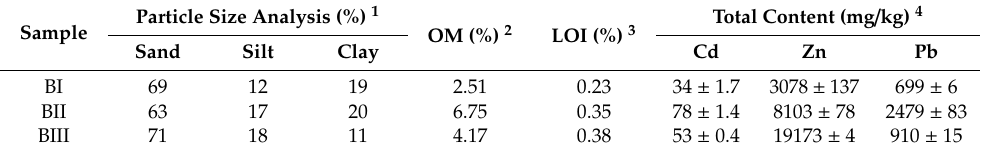
Table 1. Selected properties and concentrations of Cd, Zn, and Pb in the soils from BI, BII and BIII points [53].